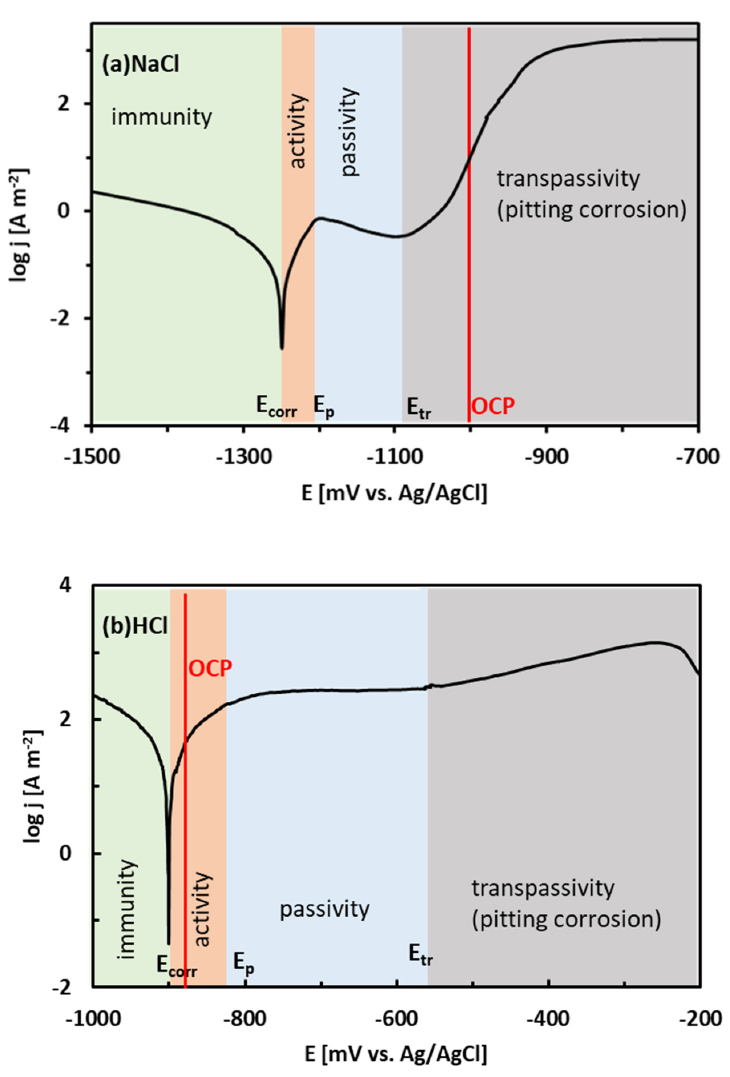
Figure 7. Position of the experimental open-circuit potential (OCP) of the Sn–15Zn alloy on the potentiodynamic polarization curve in NaCl ( a ) and HCl ( b ) solutions. Regions of immunity, activity, passivity, and transpassivity are indicated by different colors.